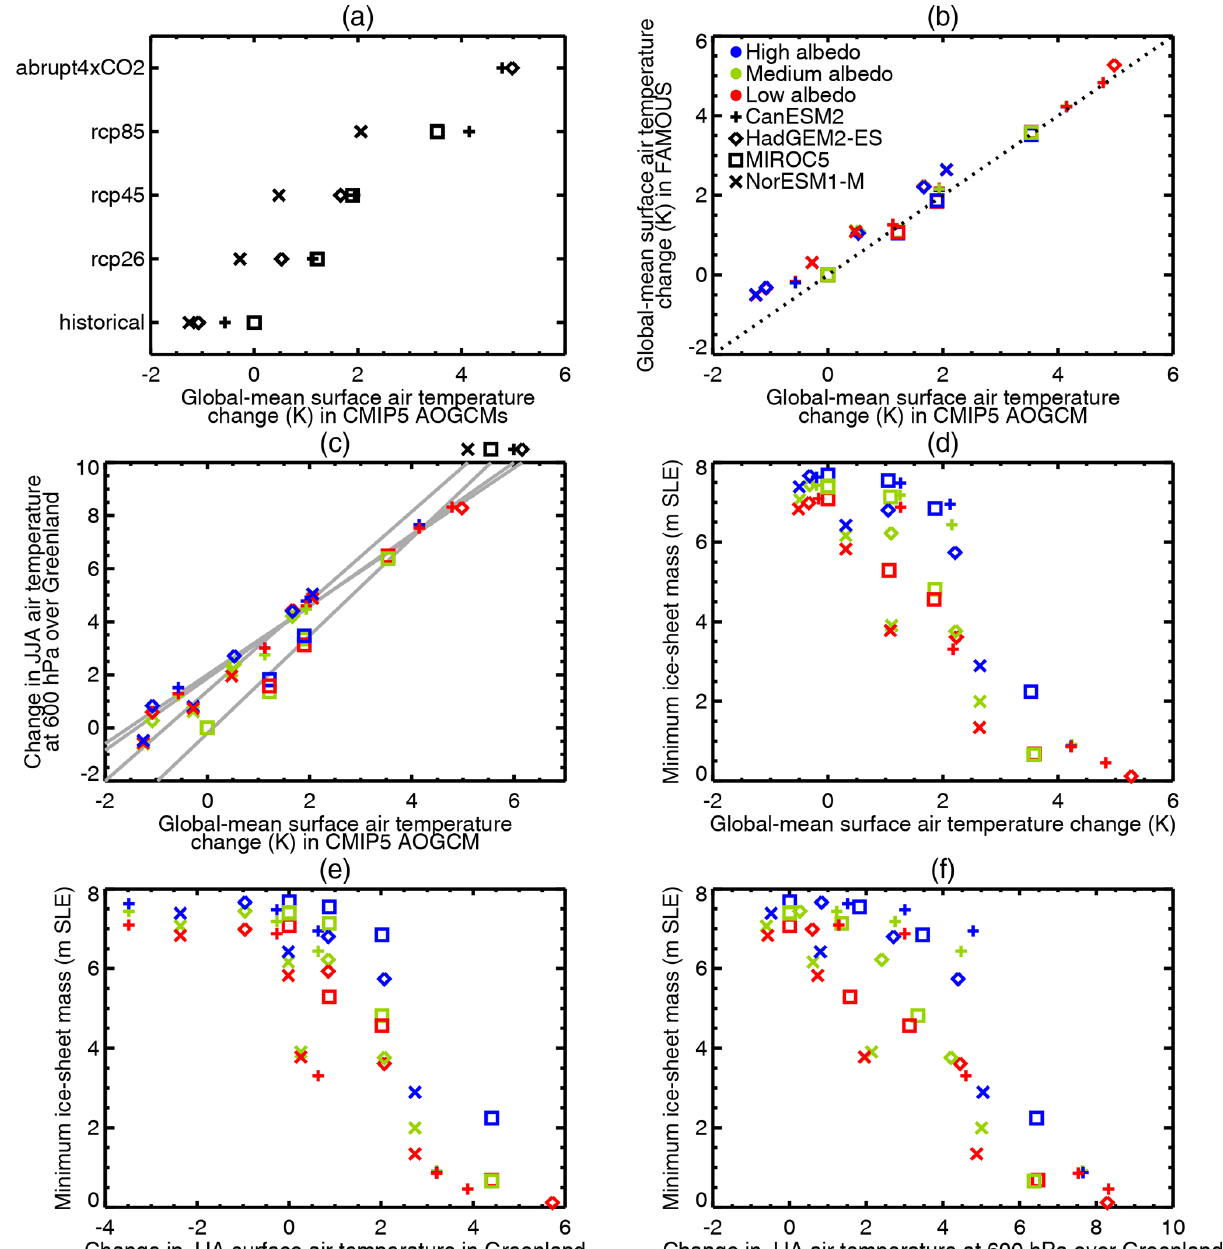
Figure B1. Relationships among air temperature change and Greenland SMB change in CMIP5 AOGCM and FAMOUS–ice–Greenland experiments. The dotted line in (b) is 1 : 1. The grey lines in (c) are regression lines for the subset of data from each of the four AOGCMs, indicated by the symbols along the top edge. Panel (d) is the same as Fig. 2c and repeated here for comparison. Changes are computed from the first 300 ice sheet years and expressed relative to the MIROC5 historical climate with the same albedo